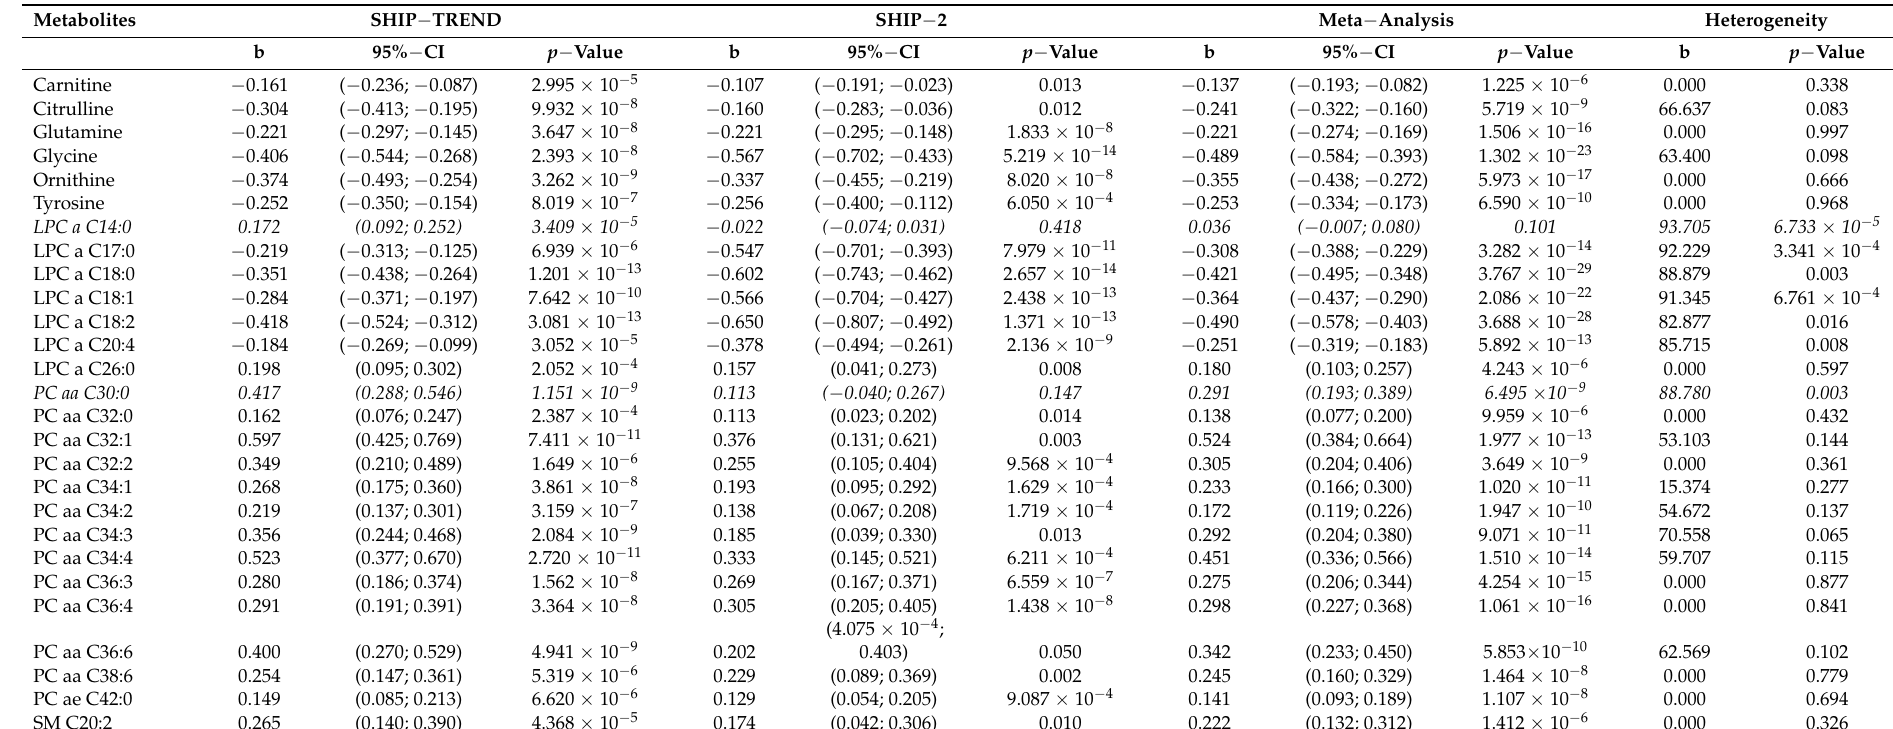
Table 3. Metabolites associated with OC